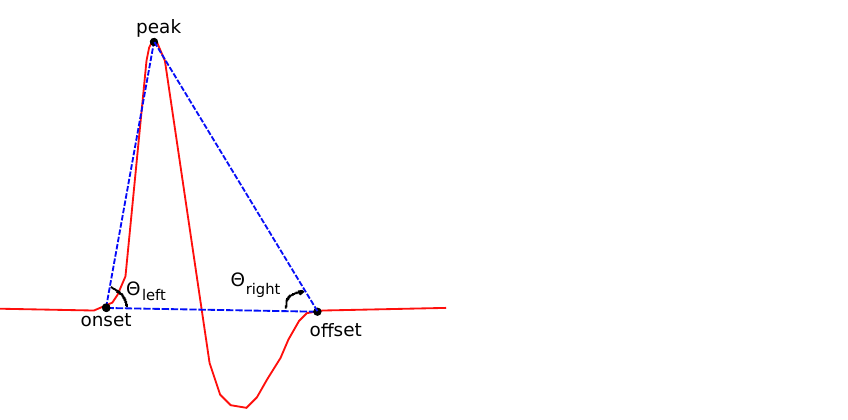
Figure 8. Features related to slopes based on onset, offset and peak points.